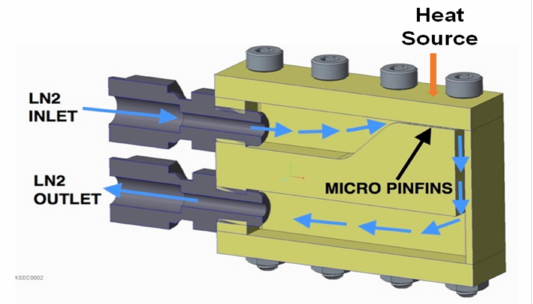
Figure 2. Cross-section of the cryogenic micro-pin fin cooler.